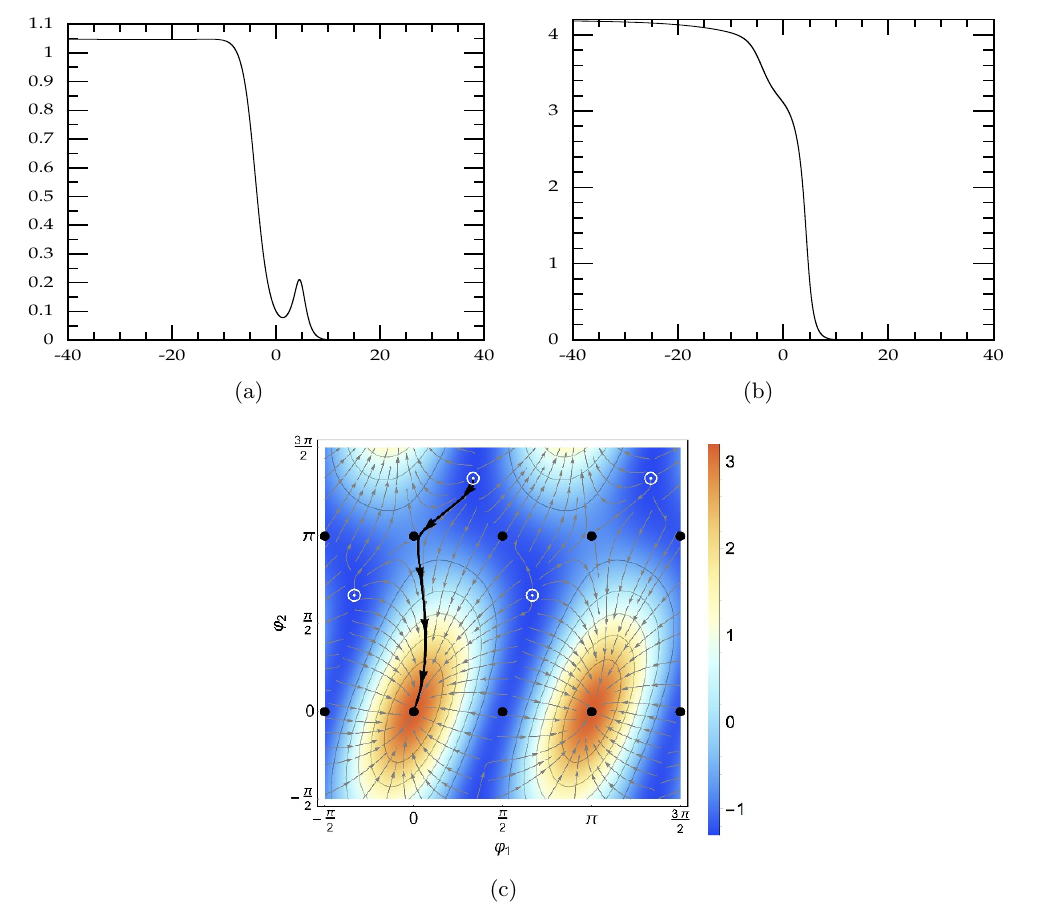
Figure 14 . SO(5) (cid:12)elds | case II; (a) ’ 1 , (b) ’ 2 and (c) ~ r (cid:17) U (cid:0) (cid:13)ow. Black dots denote the maxima and saddle points of the pre-potential that correspond to the vacua (7.3) whereas minima of the pre-potential are denoted by (cid:12) . They are localized at